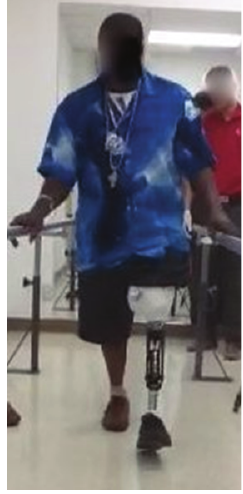
Figure 6: Patient 2 months after amputation, during routine physical